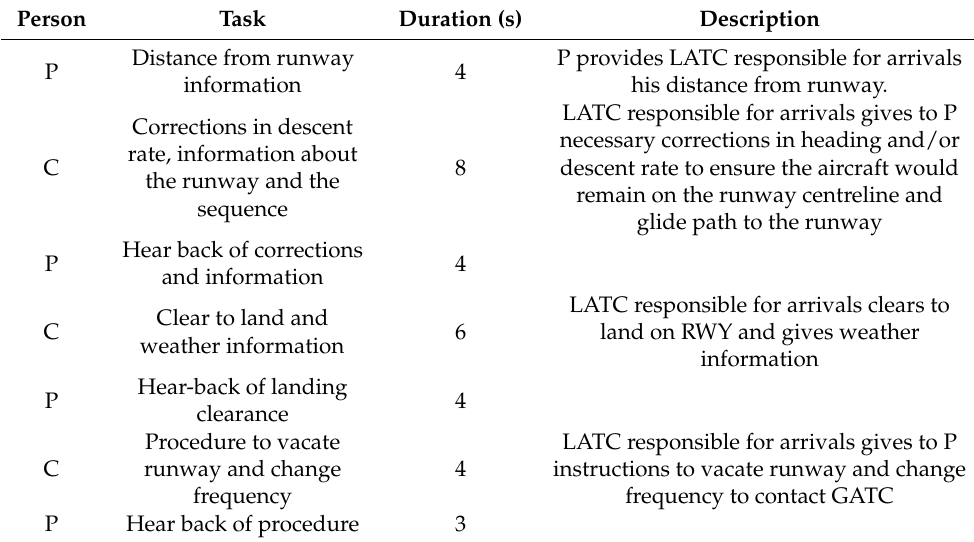
Table 4. Tasks of LATC responsible for